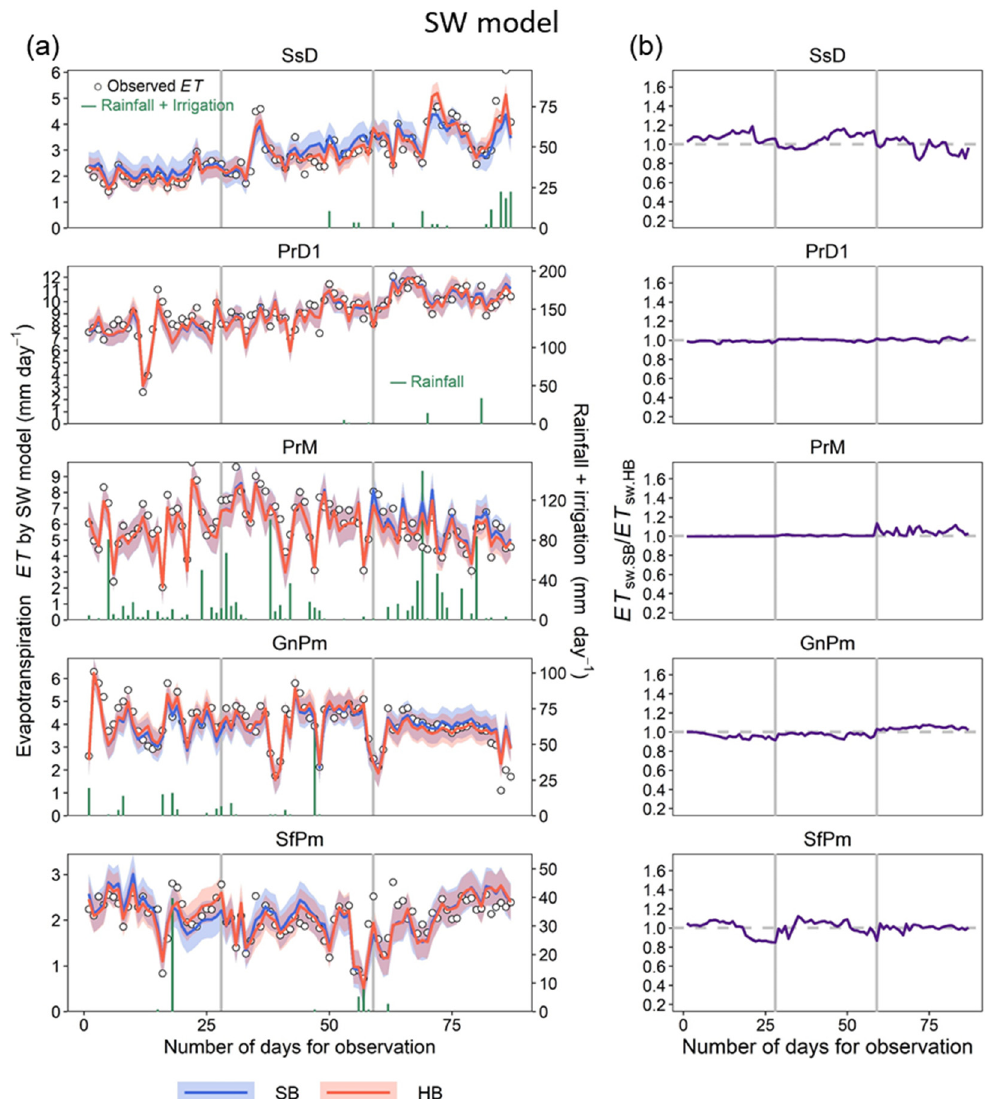
Figure 5. ( a ) Observed and estimated evapotranspiration ( ET ) using the Shuttleworth–Wallace (SW) model with parameters calibrated using simple Bayesian (SB) and hierarchical Bayesian (HB) approaches. Lines and bands corresponding to the posterior means and confidence intervals at the 95% probability, respectively, in all five observation conditions. Vertical bars indicate the rainfall + irrigation amount for the SsD and rainfall only for the others. ( b ) Variations in the values of ET sw.SB and ET sw.HB calculated from ET estimates by the SW model using SB and HB. The three calibration periods for HB are separated by vertical lines.